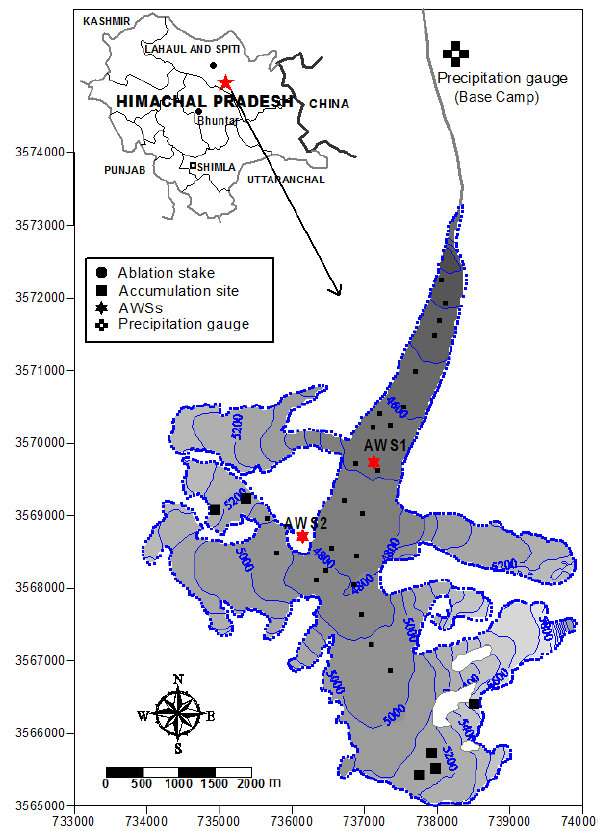
Figure 1. Map of Chhota Shigri Glacier showing the ablation stakes (black small squares), accumulation sites (black big squares), AWSs (red stars) and precipitation gauge (black cross). The map coor- dinates are in the UTM43 (north) World Geodetic System 1984 (WGS84) reference